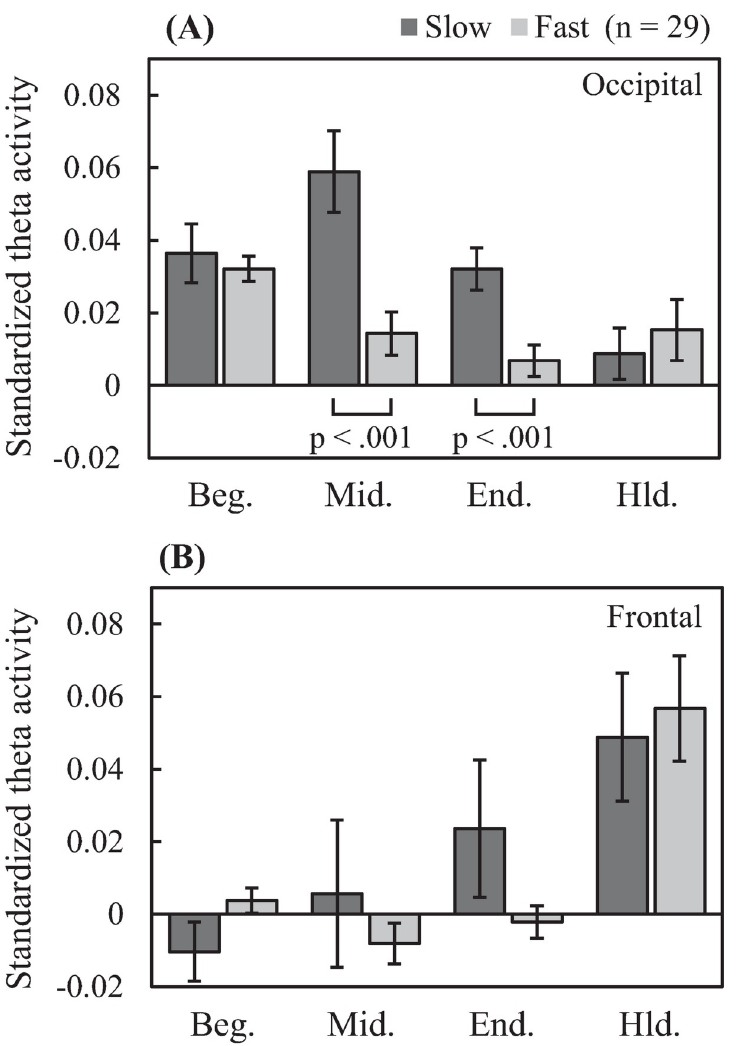
Fig 7. Time-integrated comparison region-specific standardized cortical theta activity between tasks according to task period/sub-period. Occipital-theta activity is greater for the slow task than the fast task in the midterm and ending sub-periods. (Beg.: beginning sub-period, Mid.: midterm sub-period, End.: ending sub-period, Hld.: holding